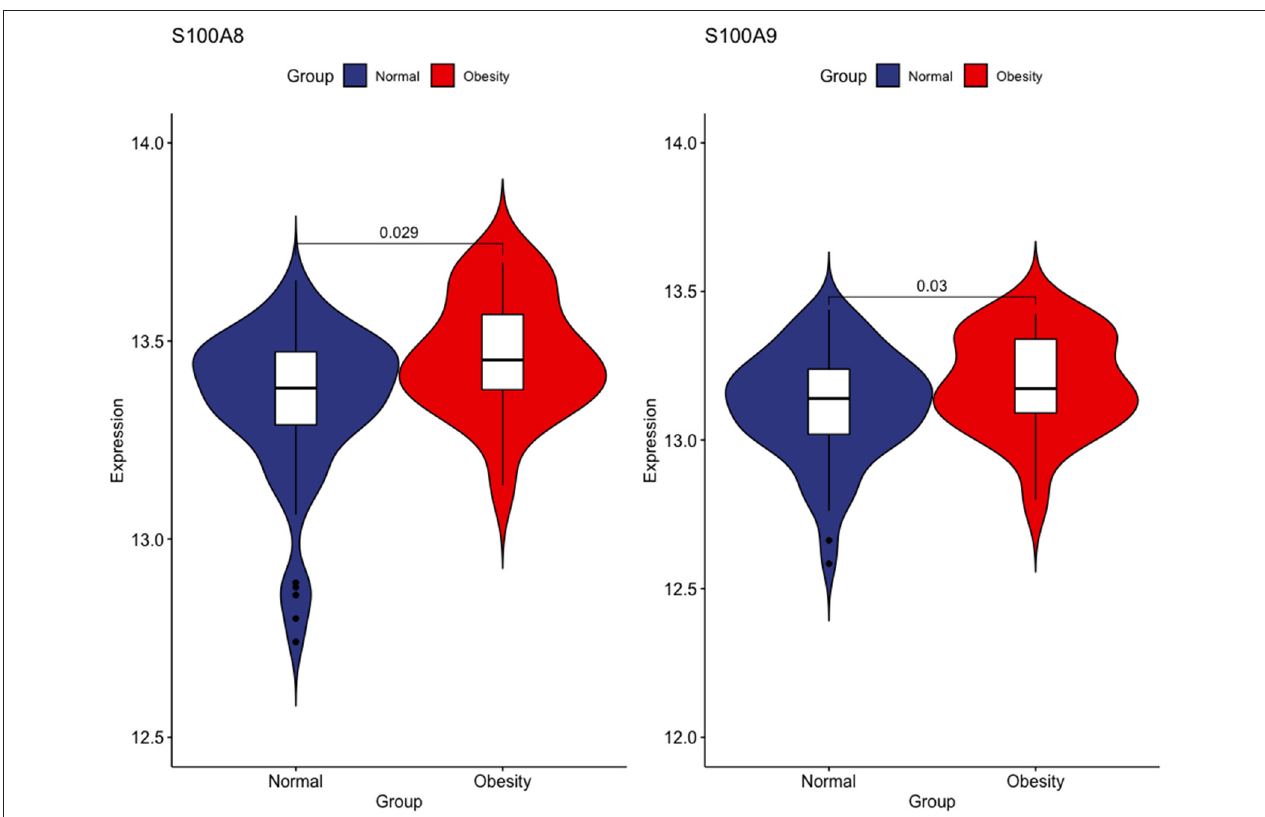
FIGURE 8 | Verification of mRNA expression between obese and healthy samples in